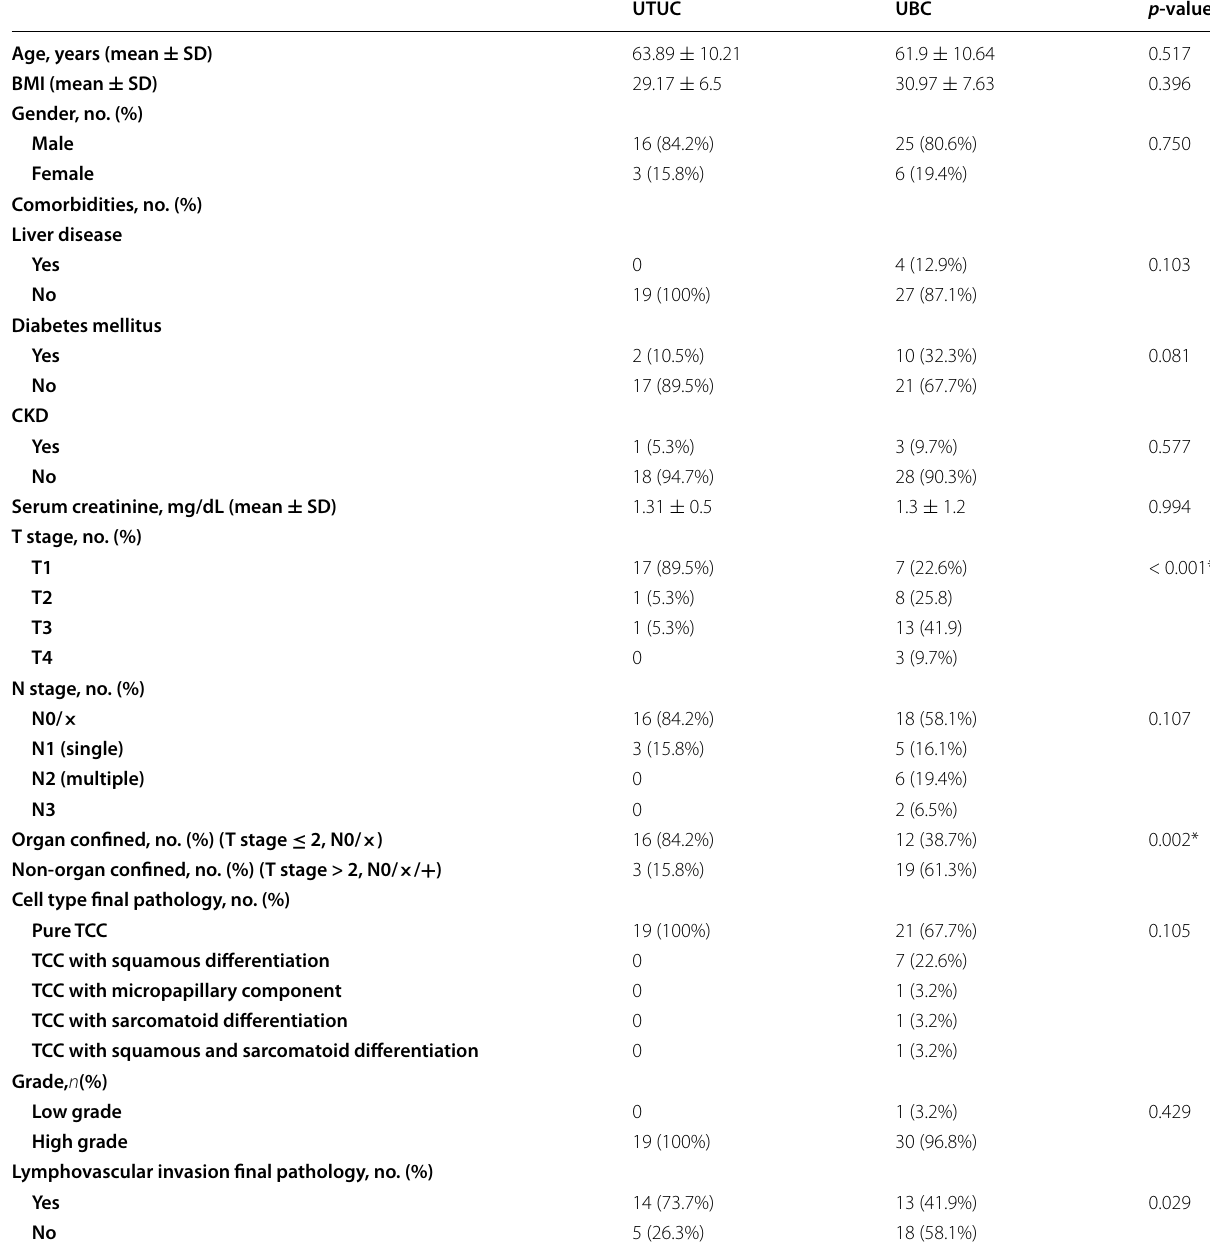
Table 2 Demographic and oncologic features of UTUC and